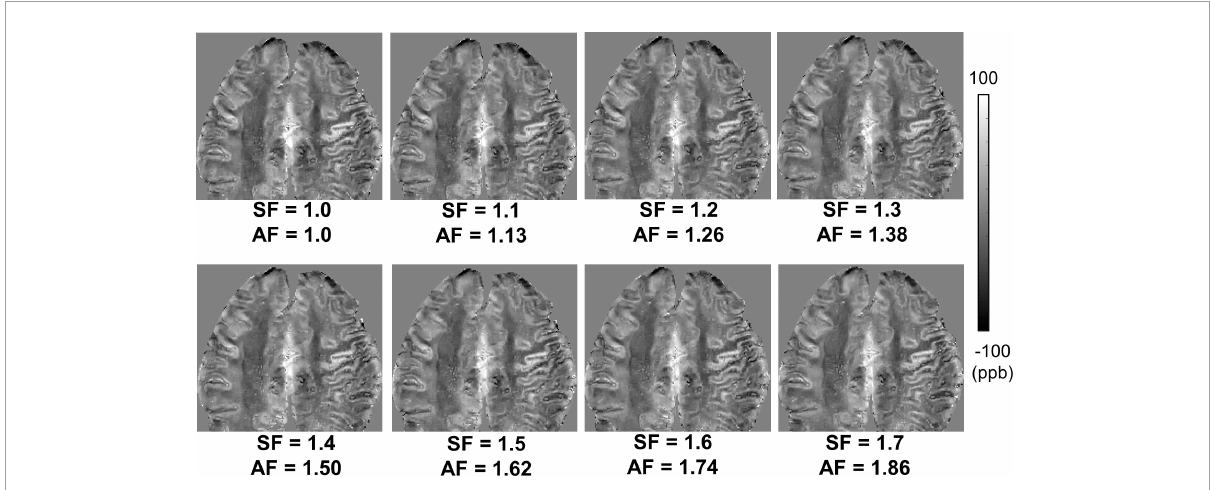
FIGURE3 Ex vivo ultrashort echo time quantitative susceptibility mapping (UTE-QSM) in a representative cadaveric brain (82-year-old female donor) with various stretching factors (SFs) to achieve different acceleration factors (AFs). The stretched cones trajectories dramatically reduced the total scan time (e.g., an AF of 1.86 with an SF of 1.7) without noticeable degradation in QSM.